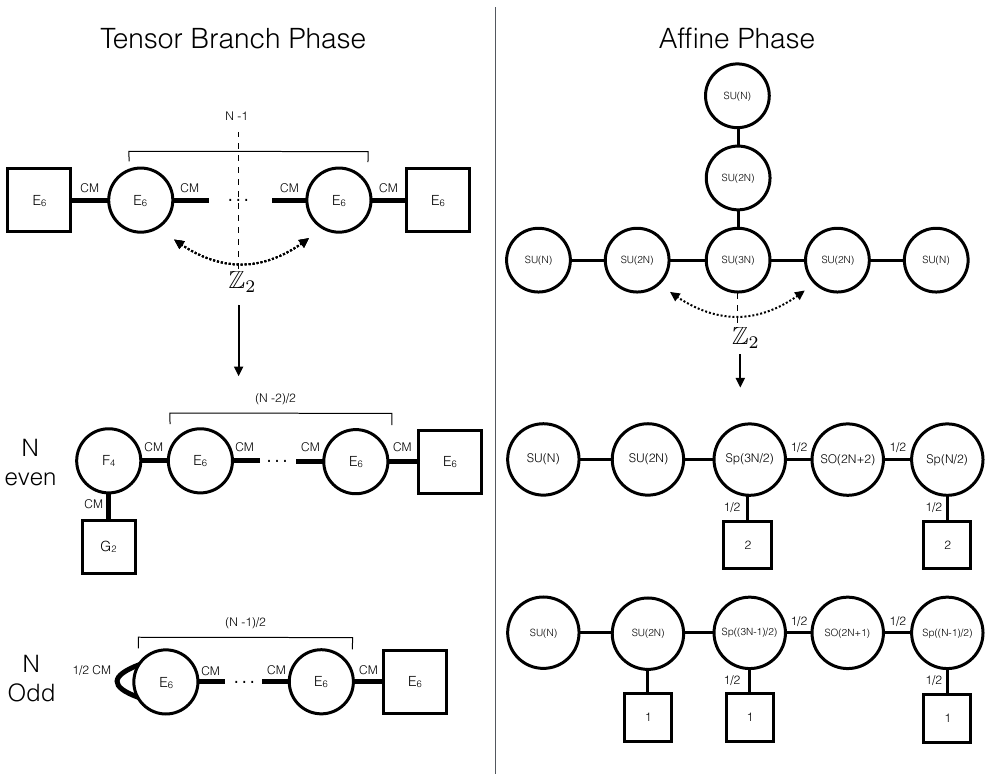
-type class S theories reduced 6 (cid:0)